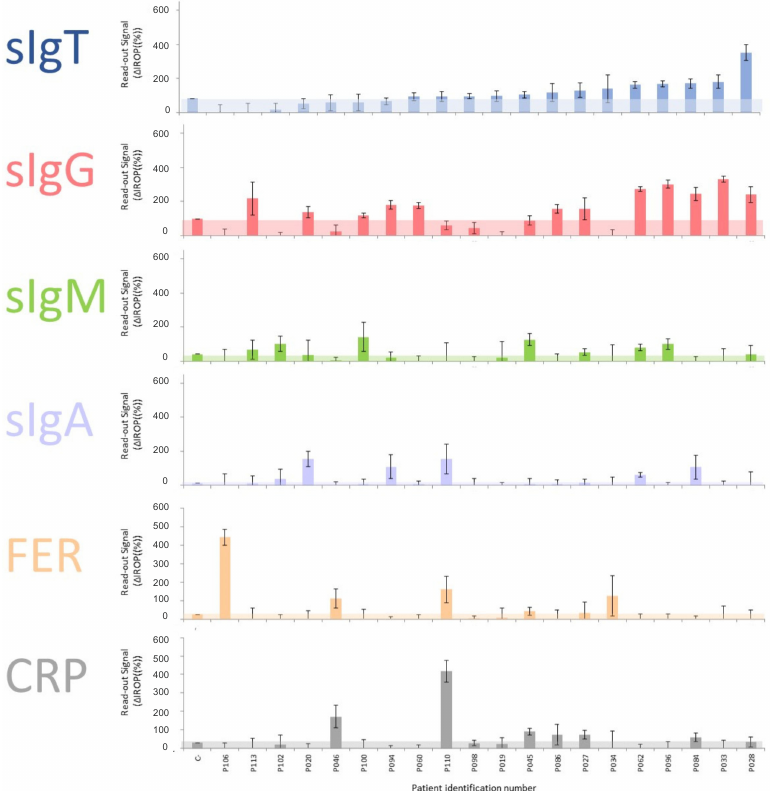
Figure 7. Asymptomatic cases of blood donors at the end of February 2020. Abbreviations: total specific Immunoglobulins (sIgT), specific Immunoglobulins G (sIgG), specific Immunoglobulins M (sIgM), specific Immunoglobulins A (sIgA), together with Ferritin (FER), C Reactive Protein (CRP) and ∆ IROP (%) (Increased Relative Optical Power.